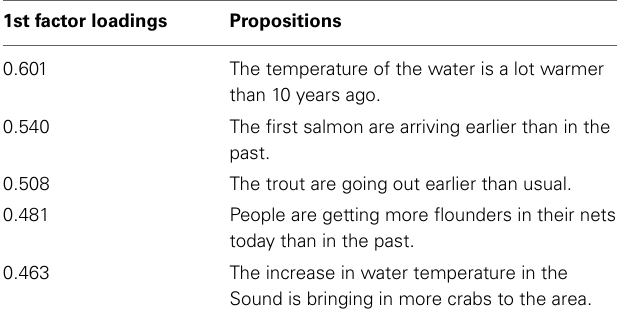
Table 2 | Factor loadings from a minimum residual factor analysis for the top five propositions used in the Climate Change Knowledge Index